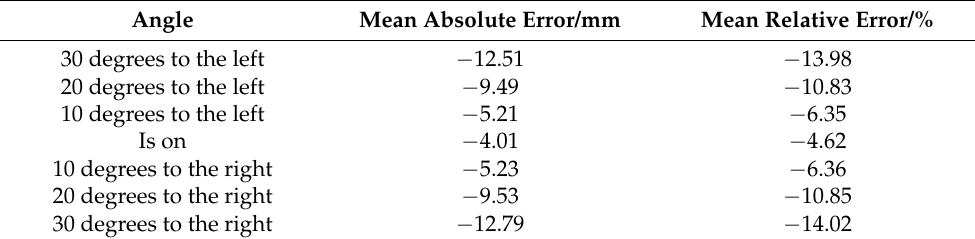
Table 7. Average Diameter Measurement Error at Different Viewing Angles.